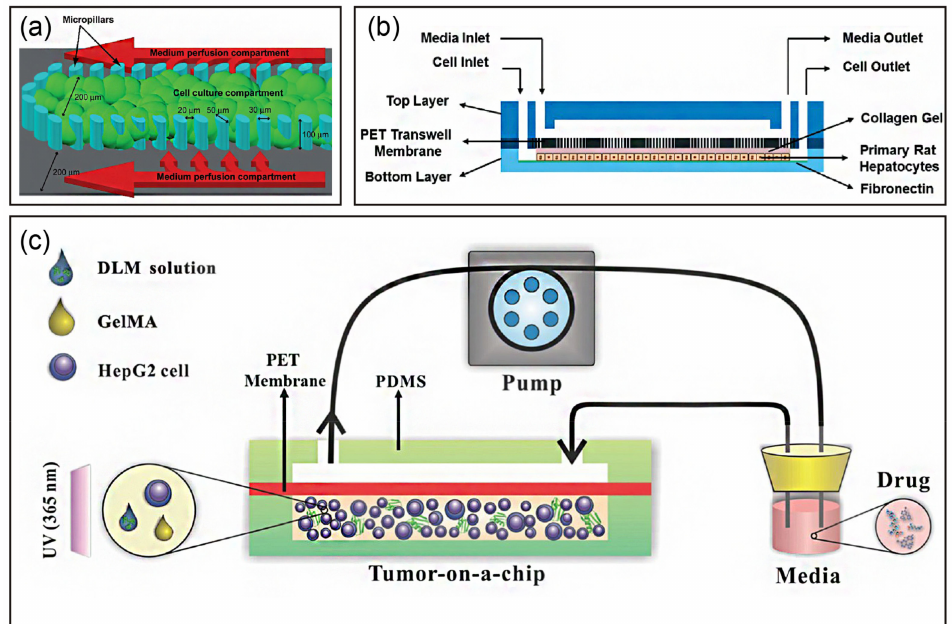
Figure 3. Strategy to build a liver-on-a-chip in matrix-dependent 3D culture: ( a ) liver cell culture channel of the multiplexed cell culture chip. Reproduced with permission from [62]. ( b ) Cross-sectional view of the assembled device showing that hepatocytes in collagen gel are introduced and cultured in the bottom layer and growth medium is introduced through the top layer. Reproduced with permission from [70]. ( c ) Schematic of HepG2-laden decellularized liver matrix with gelatin methacryloyl (DLM-GelMA) in a microfluidic device. Hydrogel precursors are injected into a microfluidic device using a pipette and photopolymerized by UV exposure to form HepG2-laden DLM-GelMA for subsequent drug screening. Reproduced with permission from